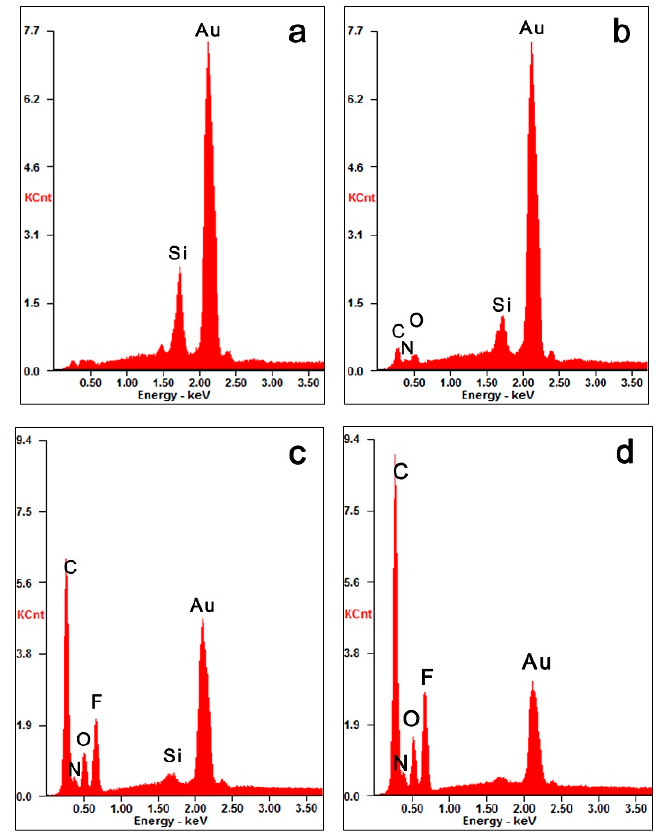
Figure 3. SEM-EDX spectra of different sensor surfaces: ( a ) unmodified gold sensor surface; ( b ) polydopamine (PDA) coated sensor surface; ( c ) perflourophenylazide (PFPA) immobilized sensor surface; ( d ) carbohydrate sensors.